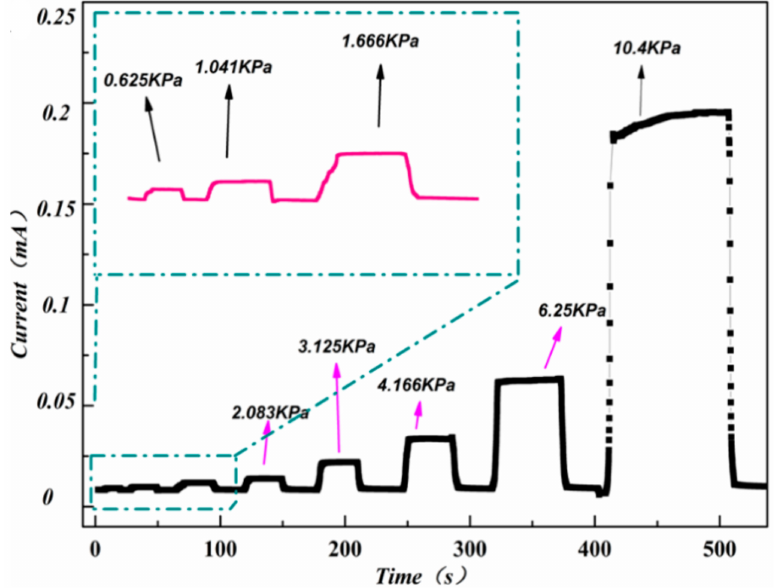
Figure 6. Real-time current response of reduced graphene oxide / polyurethane (rGO / PU) composite foam under di ff erent